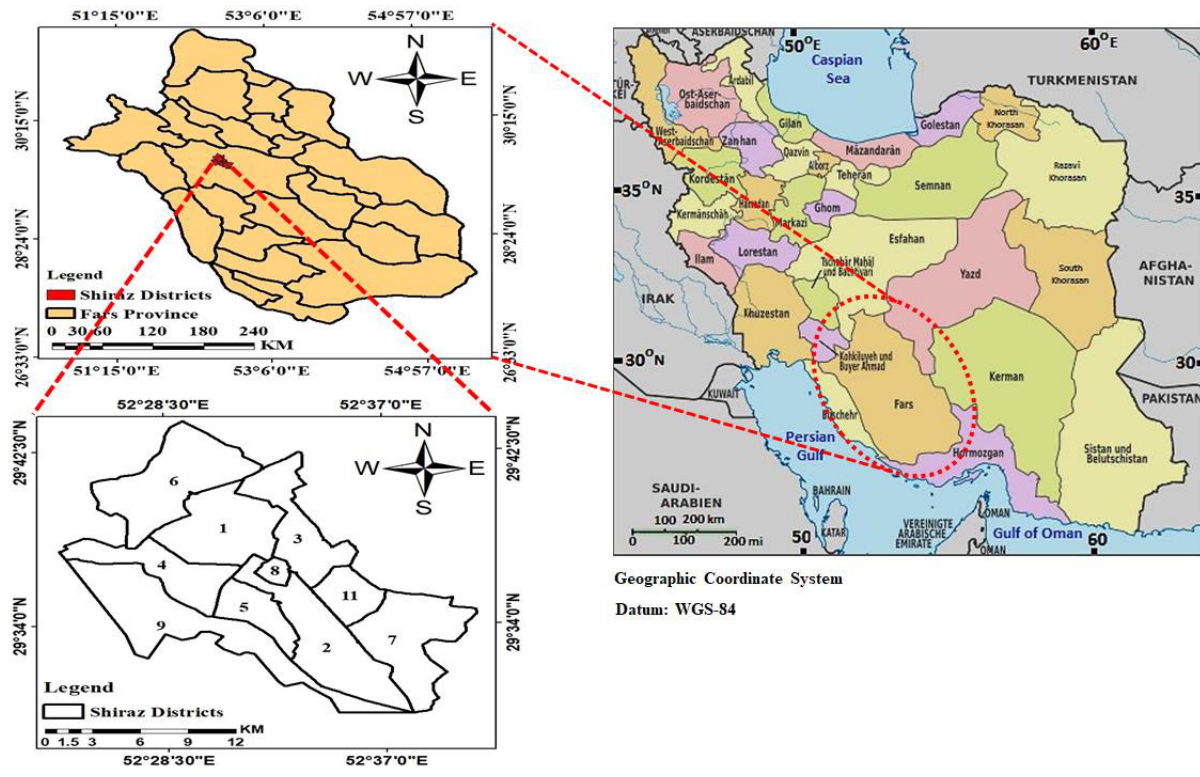
Figure 1. The geographical location of Shiraz in Iran and Fars province, and districts of 1 to 9, and 11 in this city. 2.1.2